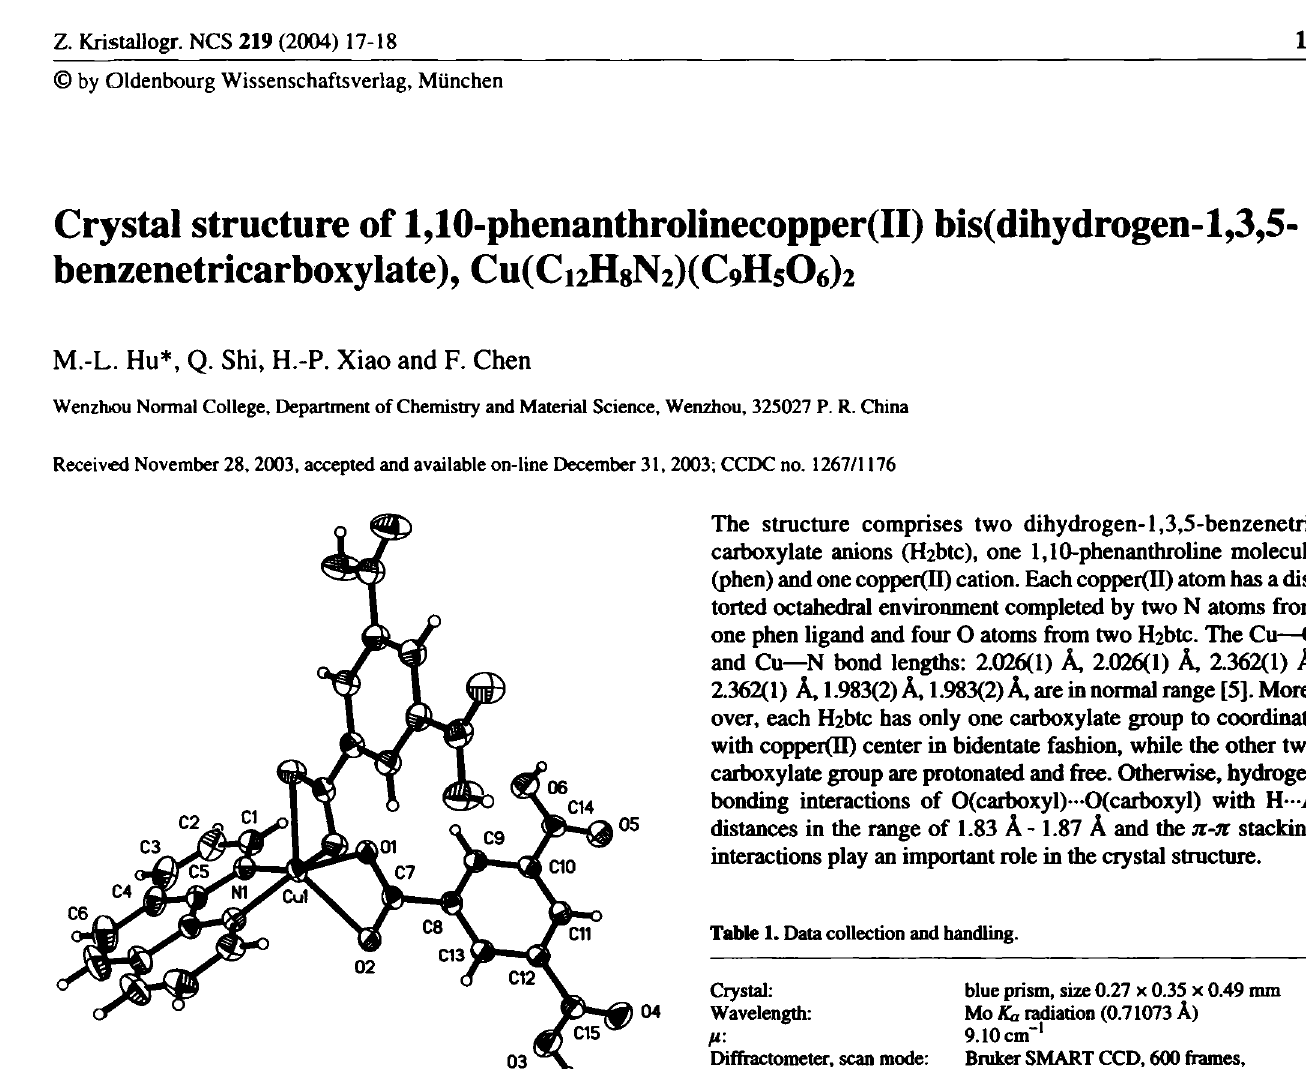
Table 2. Atomic coordinates and displacement parameters (in Â 2